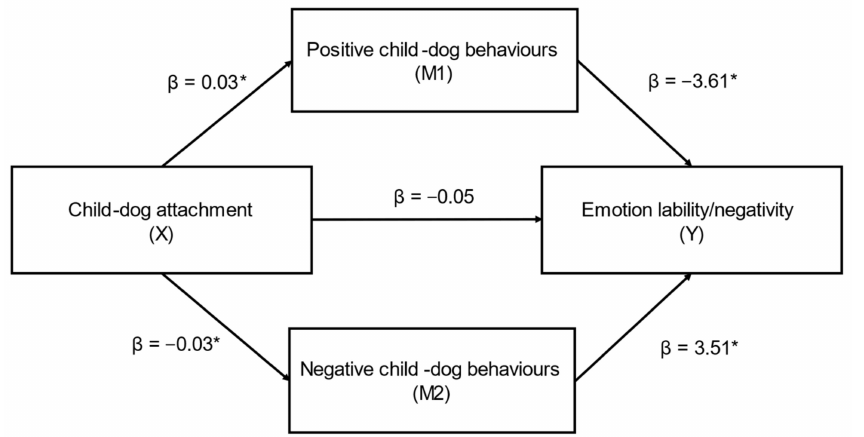
Figure 6. Positive and negative child–dog behaviours as mediators in the relationship between child–dog attachment and emotional lability/negativity (L/N subscale) ( n = 83) (ab cs = − 0.36, large effect). Note: * = significant